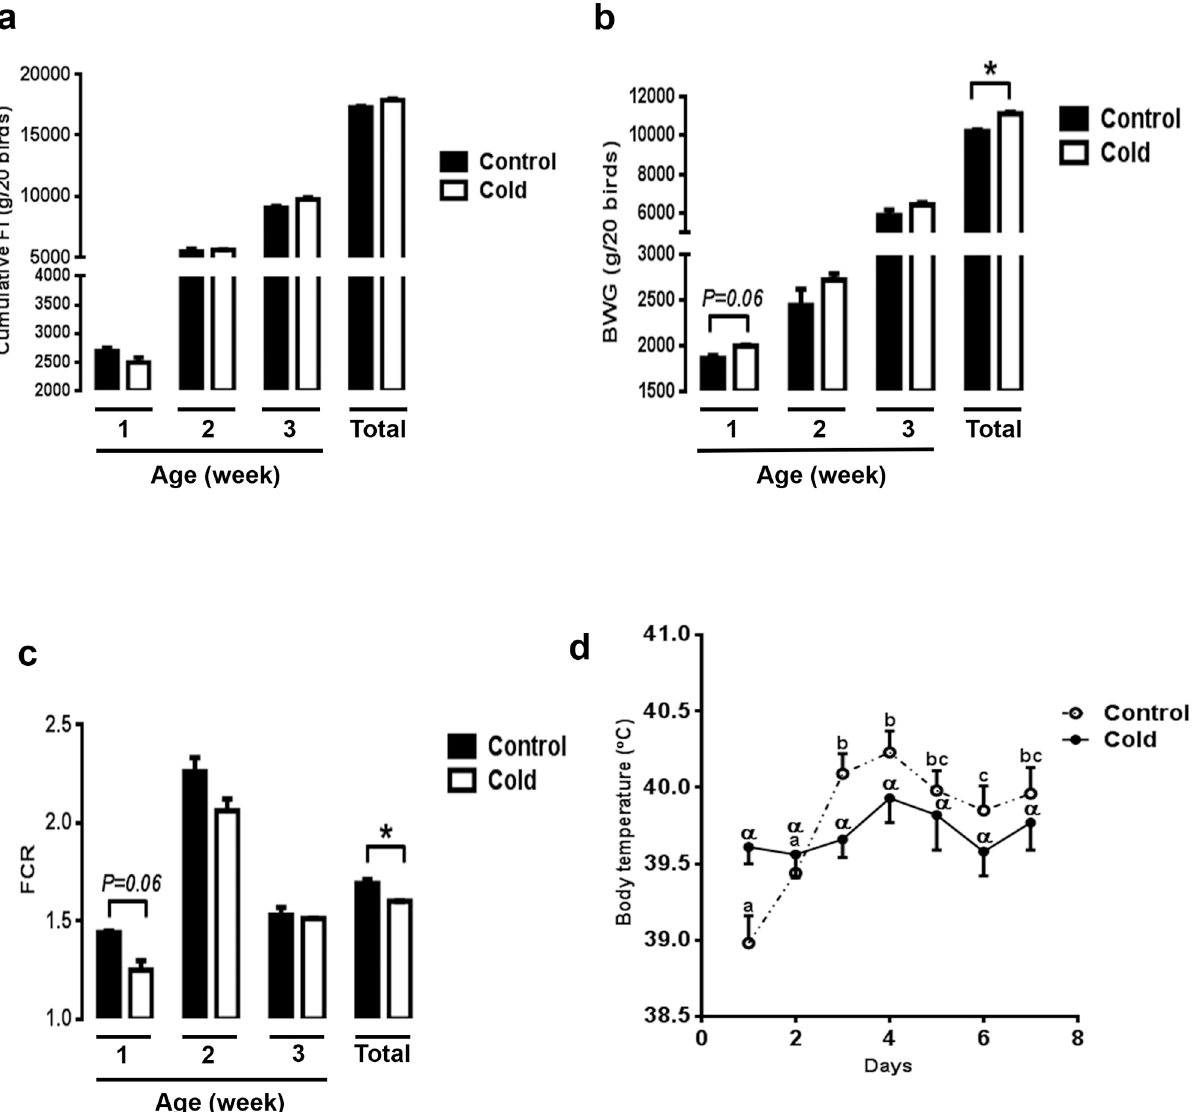
Fig 1. Effect of CMCC on growth performances in young broiler chicks. Cumulative feed intake FI (a), body weight gain BWG (b), feed conversion ratio FCR (c), and body temperature (d). Data are presented as mean ± SEM (n = 40) for each week and for the total experimental period (3 weeks). * P < 0.05. Different letters indicate daily difference in body temperature within each group (a-c and α , difference within control and cold group, respectively).